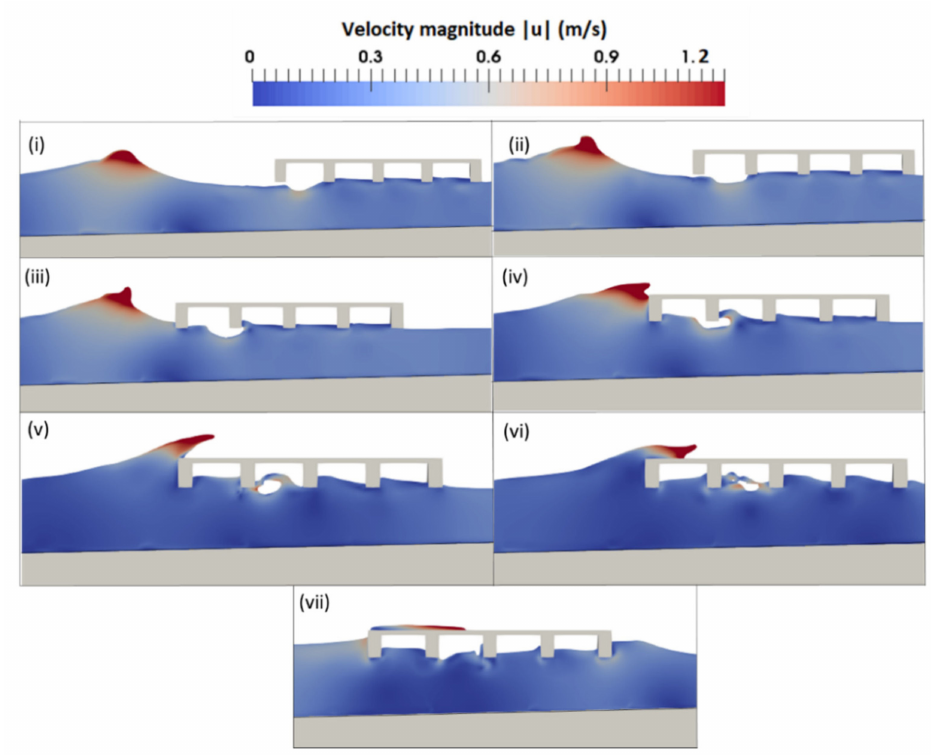
Figure 12. Velocity variation during breaking wave impact scenario WI-2 with the coastal deck struc- ture at normalized airgap ( S/d = 0.18) at different time steps ( i ) t = 15.9 s ( ii ) t = 16.05 s ( iii ) t = 16.15 s